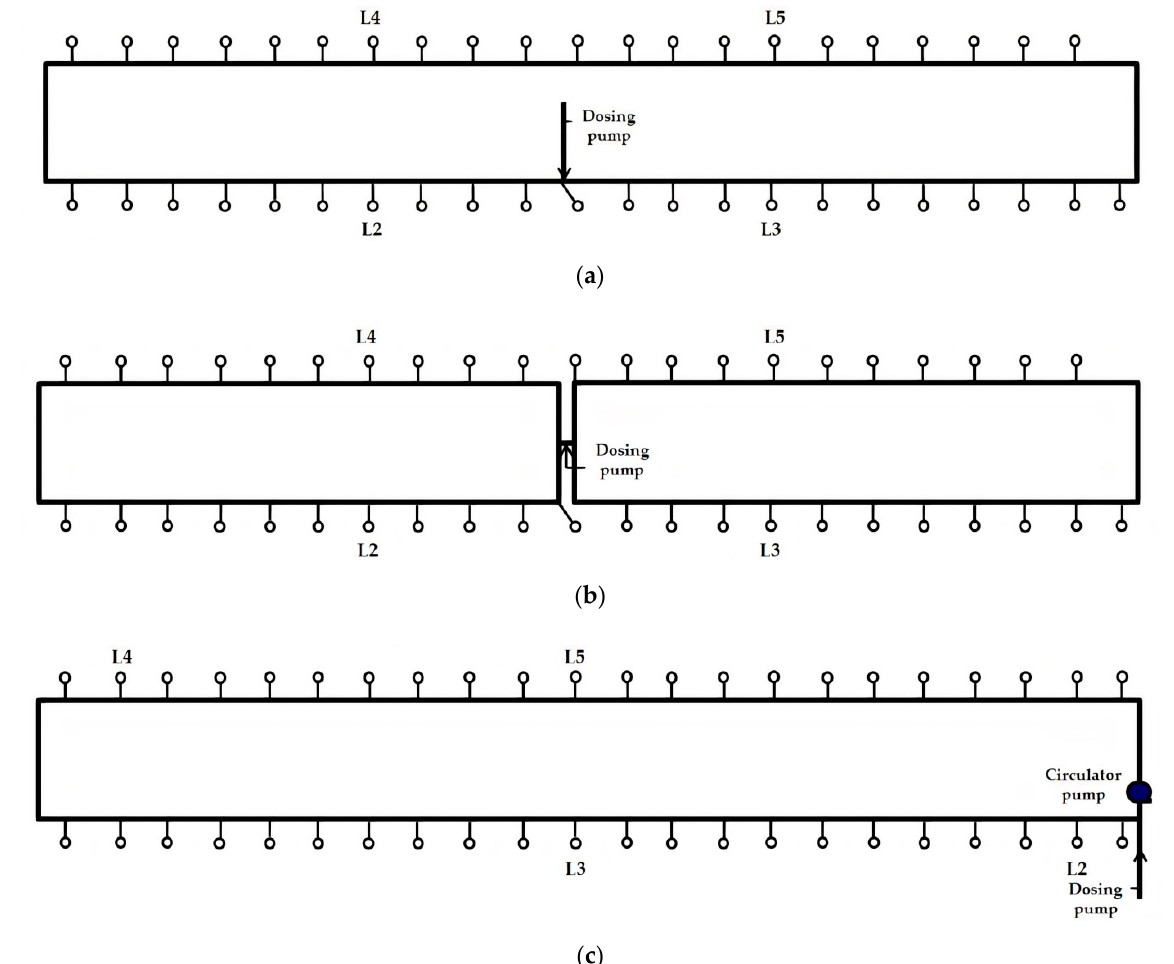
Figure 2. Schematics of looped WDSs in pig grower/finisher buildings: ( a ) Study 1a in Building A, ( b ) Study 1b in Building A, and ( c ) Studies 2a and 2b in Building B. Drinkers are represented with open circles. Drinkers from which water samples were collected for analysis are labelled L2, L3, L4 and L5.